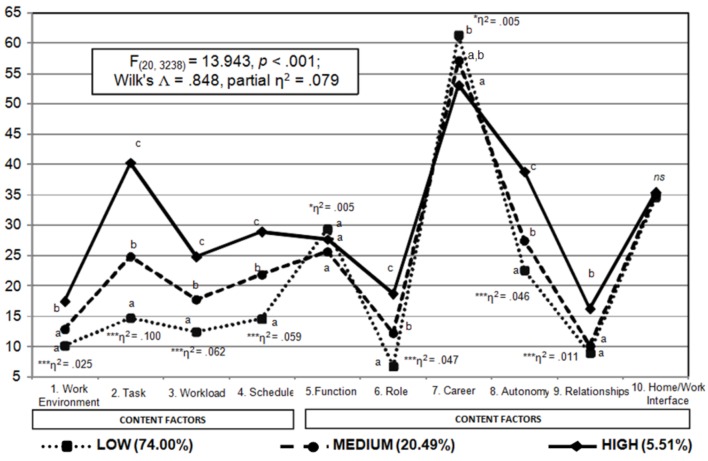
MANOVA results considering content and context factors as dependent variables and the level of risk associated with sentinel events as factor. For sake of simplicity in the interpretation, raw scores on content and context factors were rescaled on a 0–100 metric. Different superscripts denote significant differences between groups (e.g., the mean of one group is subscripted with a is significantly lower with those labeled with b, etc.). Significant principal effects are the ones indicated with asterisks, where ∗∗∗p < 0.001; ∗∗p < 0.01; ∗p < 0.05, ns, not significant. η2 reported for principal effects refer to partial η2.